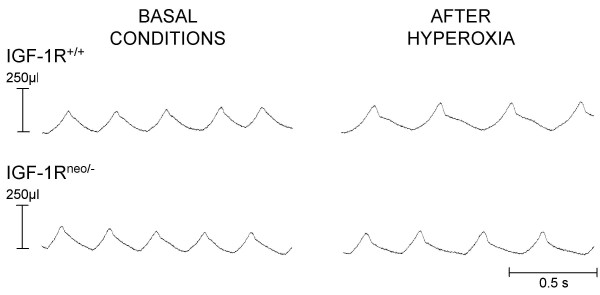
Respiratory pattern before and after hyperoxia. Typical respiratory pattern in a control IGF-1R+/+ mouse (upper traces) and in an IGF-1Rneo/- mouse (lower traces) under basal conditions and following hyperoxia. Expiratory pauses were observed in most control mice but not in IGF-1Rneo/- mice.